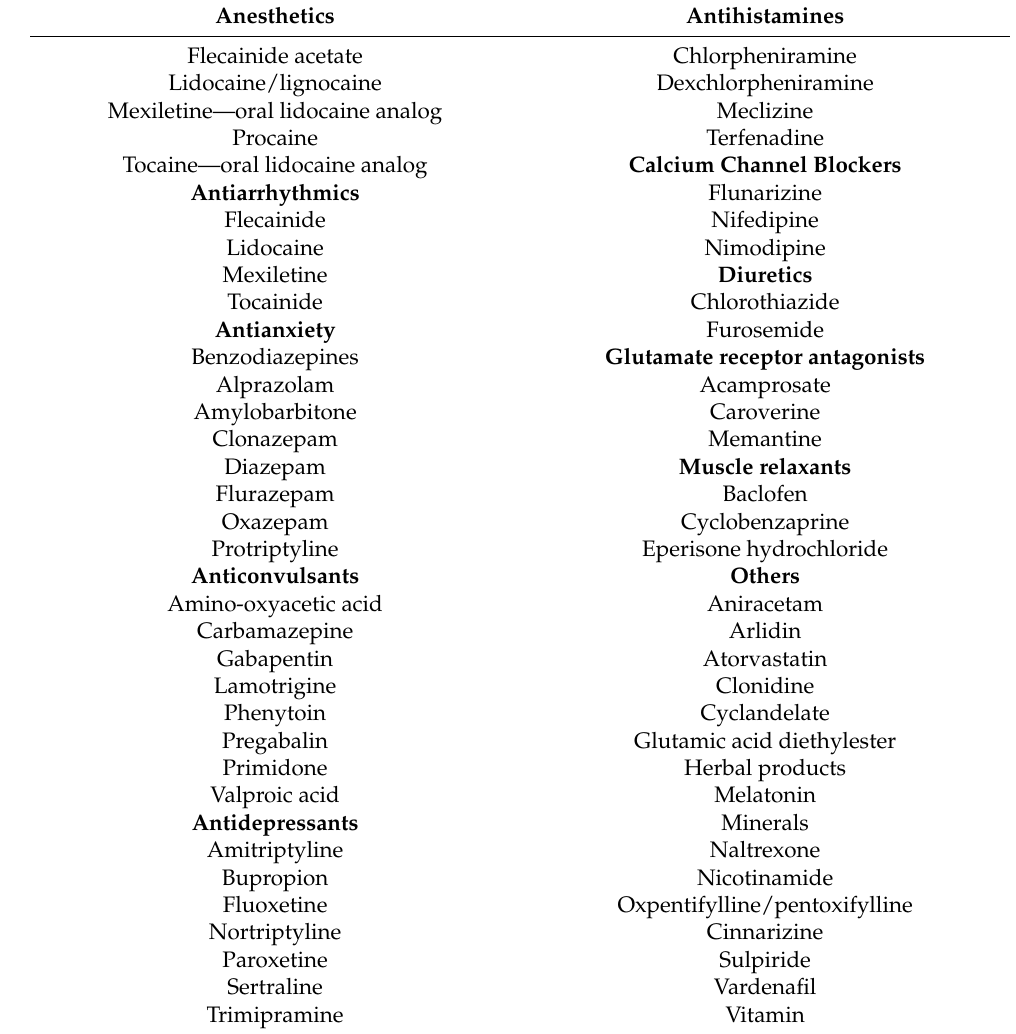
Table 1. Off-label drugs used in the treatment of